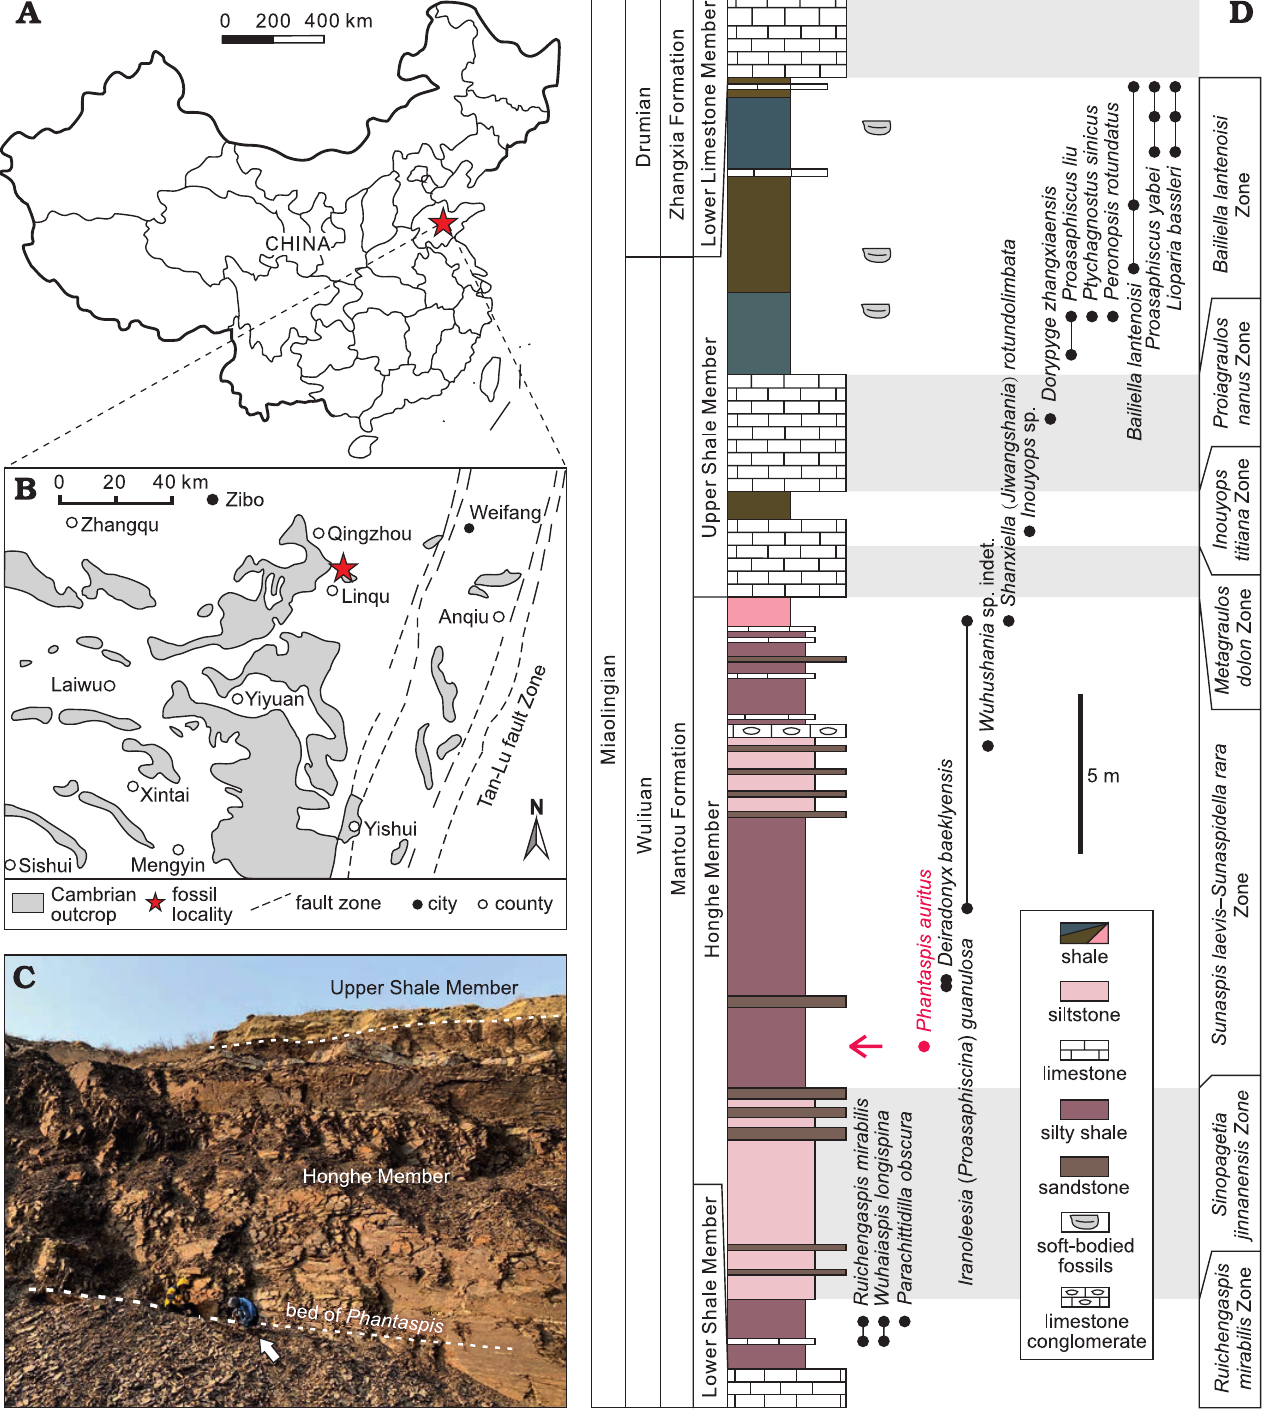
Fig. 1. A . Geographical location of studied area (star) in Shandong Province, North China. B . General geologi cal setting of the middle Cambrian Long- gang section. C . Upper part of the Honghe Member of the Cambrian (Miaolingian, Wuliuan) Mantou Formation in the Longgang section, viewed from the west. Arrow is pointed to the person for scale. D . Stratigraphic column for the Honghe and Upper Shale members and the major trilobite horizons in the Longgang section. Alternative spelling of Zhangxia is Changhia. Arrow indicates the bed yielding Phantaspis auritus gen. et sp.